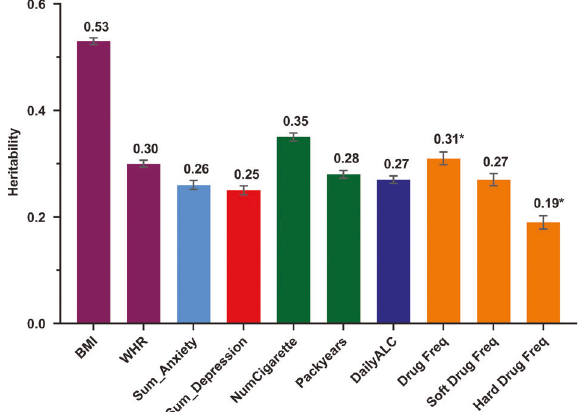
Fig. 2 Heritability estimates of obesity, anxiety, depression and substance use. BMI, body mass index; WHR, waist-hip-ratio; Sum_Anxiety, sum score of 10 items related to anxiety from MINI; Sum_Depression, sum score of 10 items related to depression from MINI; NumCigarette, number of cigarettes per day; DailyALC, daily alcohol intake; Drug Freq, lifetime drug use frequency; Soft Drug Freq, lifetime soft drug use frequency; Hard Drug Freq, lifetime hard drug use frequency. Heritability estimates adjusted for age, age 2 and sex. *Heritabilities for drug use frequency and hard drug use frequency were estimated in the bivariate model with Log converged, because of Log not converged in univariate